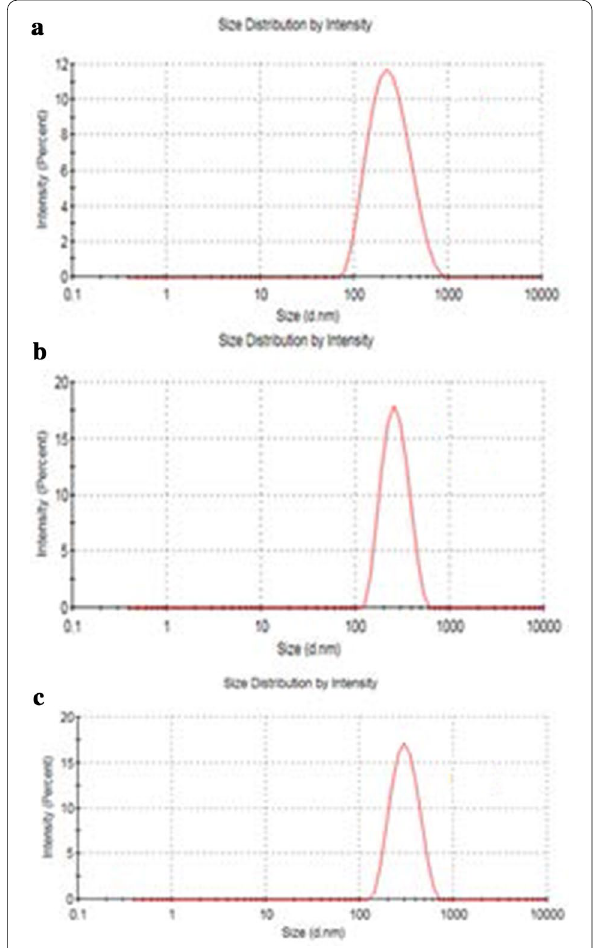
Fig. 4 Particle size of GO ( a ), Tau-GO ( b ), and 5-FU-Tau-GO ( c )